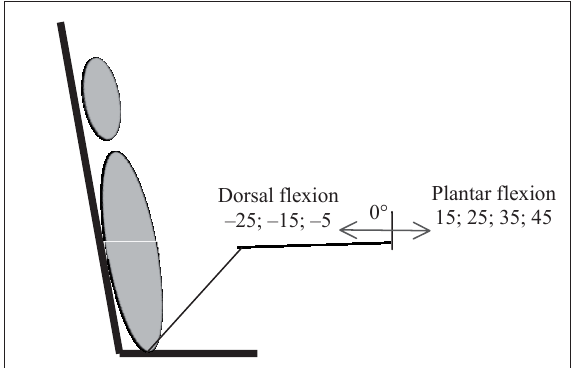
Figure 1. Testing ankle joint position during electrical stimulation- evoked and maximal voluntary contraction torque